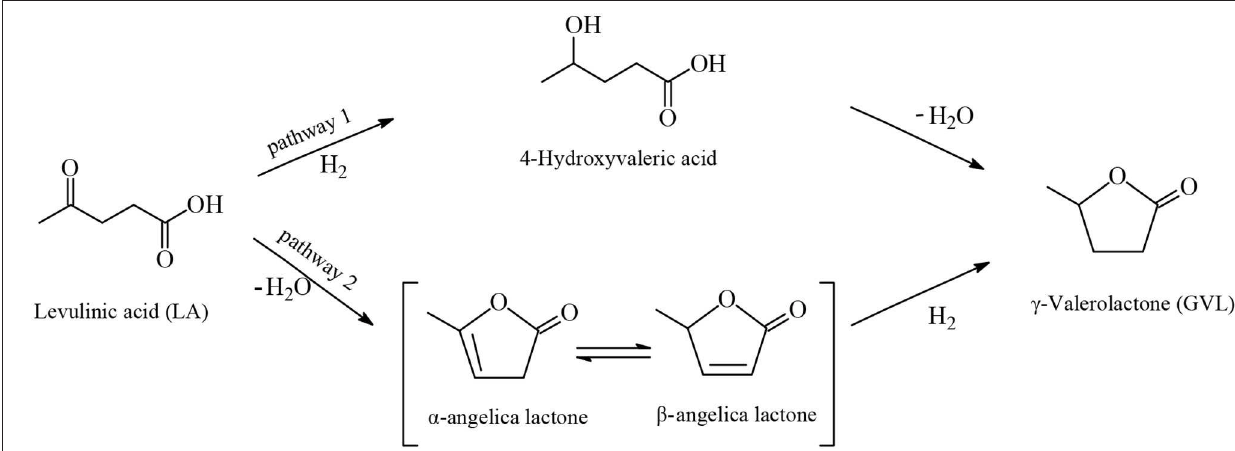
FIGURE 3 | Possible reaction mechanisms for the synthesis of GVL from LA.